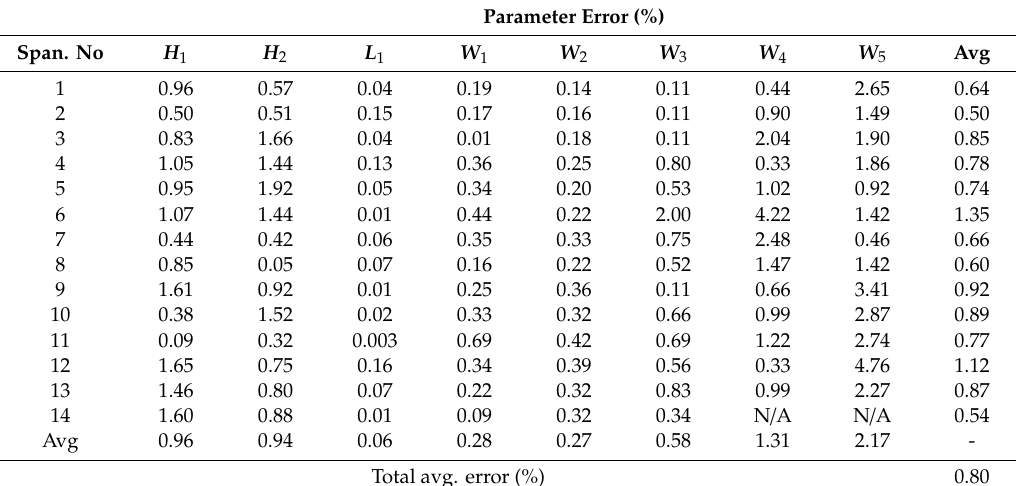
Table 2. Predicted parameters for Osong test track fifth